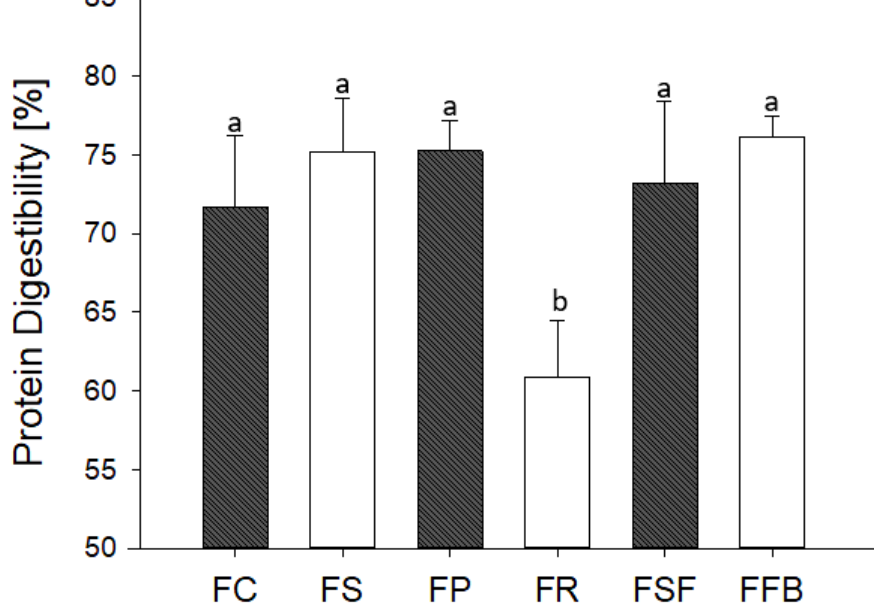
Figure 7. Effects of plant proteins as partial meat substitutes on in vitro protein digestibility of hybrid meat emulsions. Mean values with different letters on the columns of each parameter differ from each other ( p ≤ 0.05) according to the post hoc Tukey’s test. FC: control; FS: soy; FP: pea; FR: rice; FSF: sunflower; FFB: fava bean.